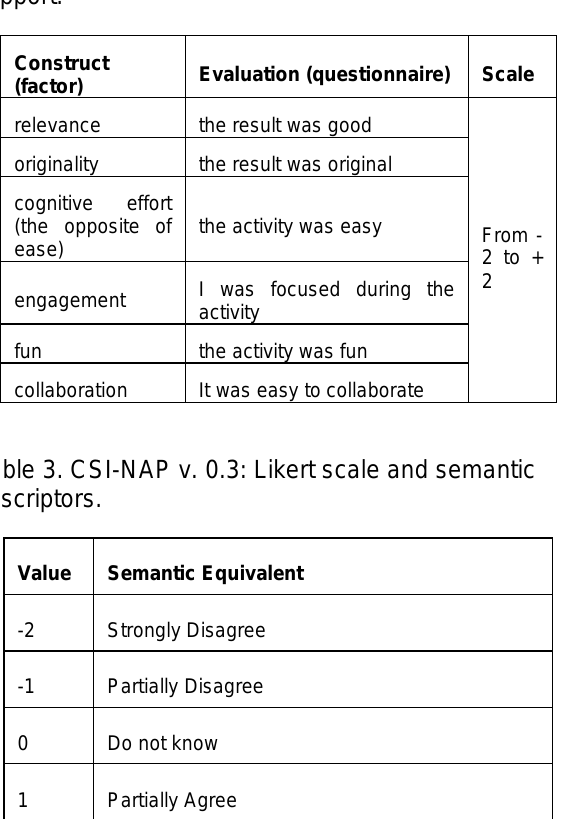
Table 2. CSI-NAP v. 0.3: assessment of creativity support.